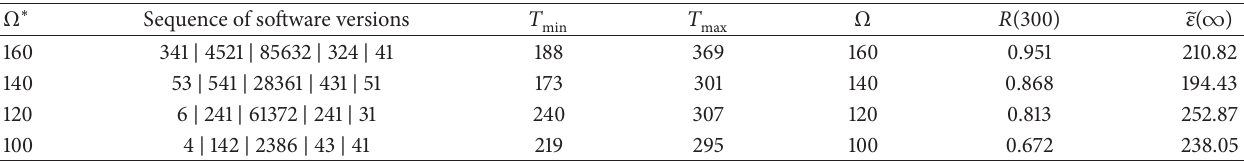
Table 3: Parameters of solutions obtained for 𝑤 = 300